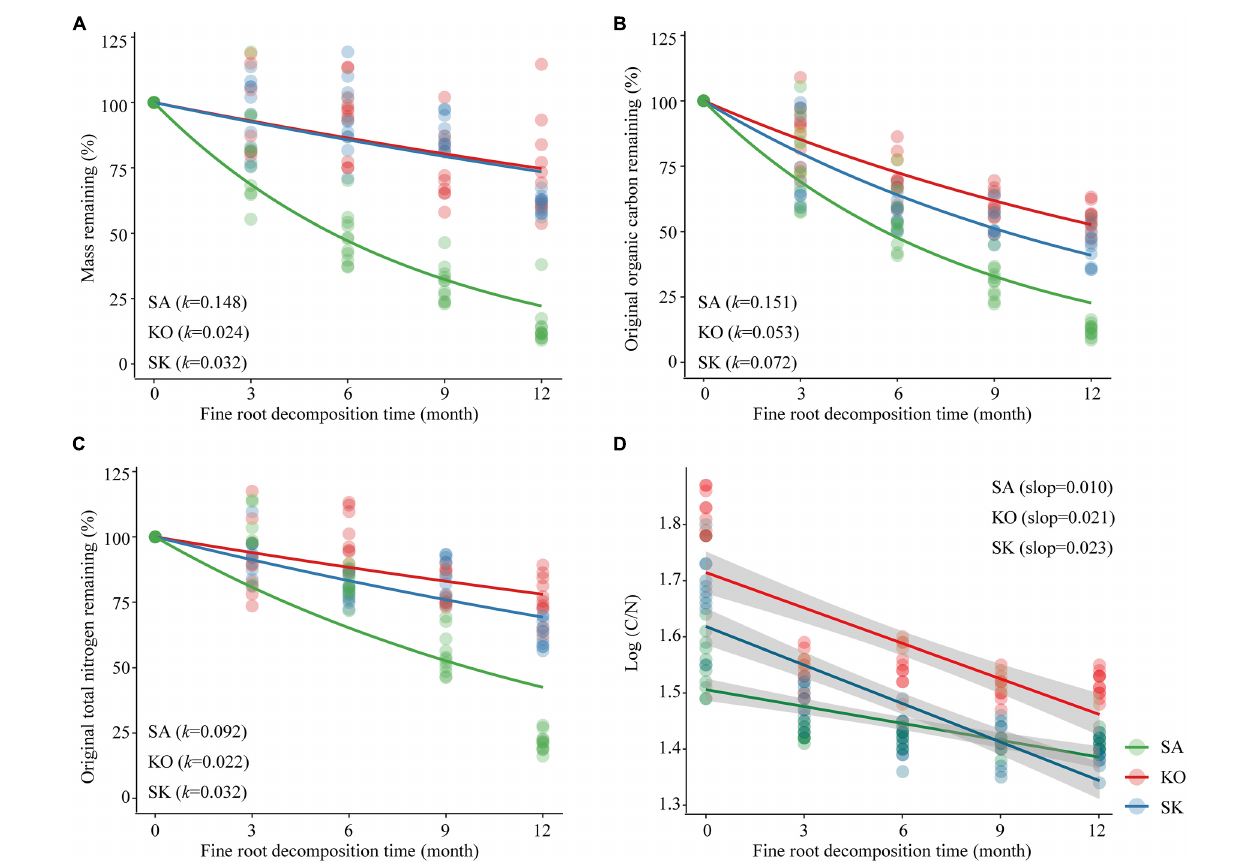
FIGURE 7 | Loss of mass (A) , organic carbon (B) , total nitrogen (C) and changes in C/N (D) for fine root of S. apetala (SA), K. obovata (KO) monocultures and the mixed (SK) plantations upon decomposition at Hanjiang River Estuary, south China. k values were estimated based on the negative exponential decay model. Data were normalized such that 100% equals the t = 0 intercept of the exponential decay regression. Linear best fits for (d): SA ( y = –0.01 x + 1.506, r 2 = 0.513); KO ( y = –0.021 x + 1.714, r 2 = 0.562); SK ( y = –0.023 x + 1.619, r 2 = 0.668). All regressions are significant ( p <